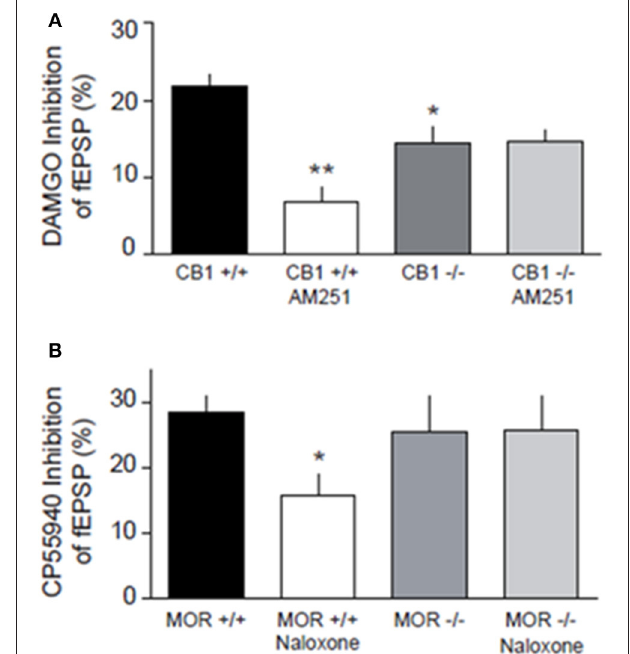
FIGURE 9 | Genetic deletion of presynaptic CB1R and MOR in the mouse alters synaptic transmission at NAcC synapses. DAMGO-induced inhibition of fEPSP is blocked by the CB1R antagonist AM251 in CB1 + / + , but not in CB1 − / − mice, and less effective in reducing excitatory transmission in CB1 − / − mice (A) . CP55940-induced inhibition of fEPSP is reduced by naloxone in MOR + / + , but not in MOR − / − mice (B) . Data represent mean ± S.E.M. percent fEPSP inhibition after drug application. * p < 0.05; ** p < 0.01 vs. DAMGO/CP55940 in CB1 + / + and MOR + / + . N = 5–8 per treatment